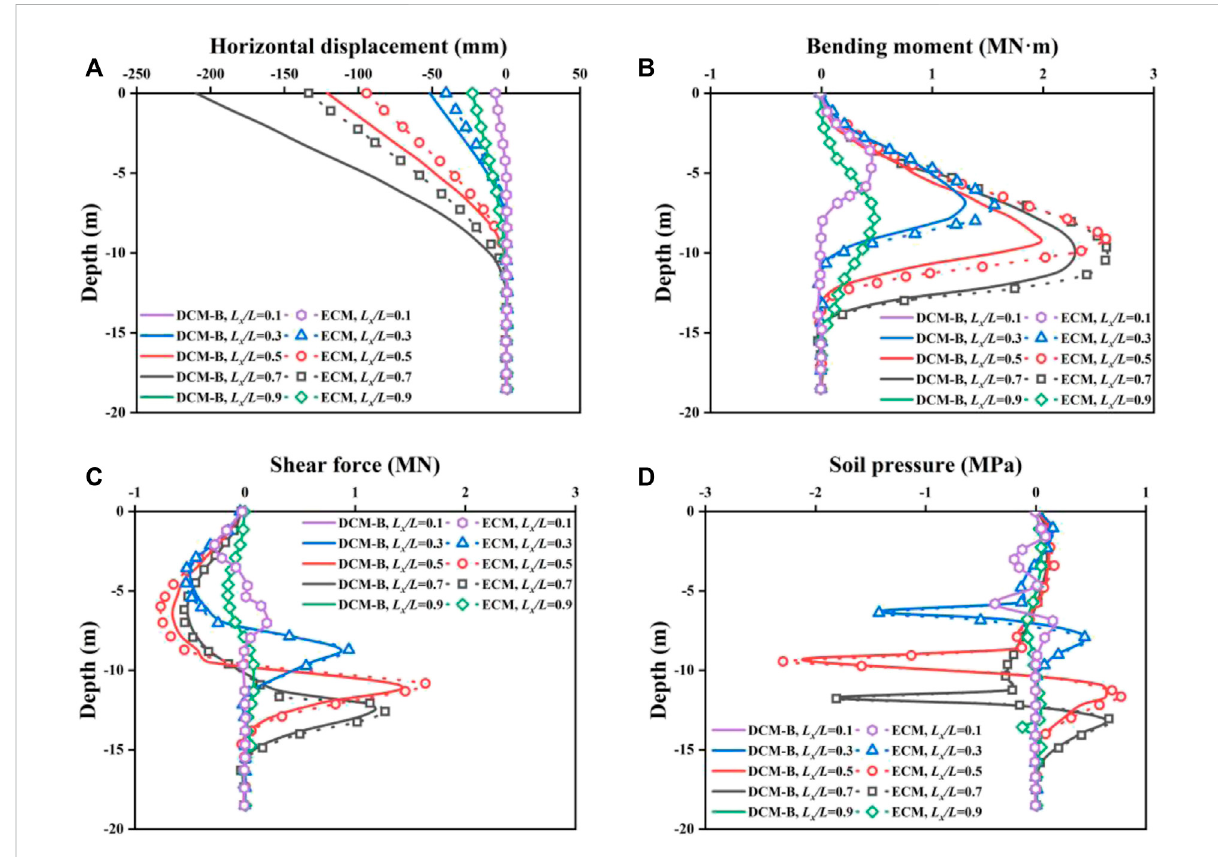
Figure 8 represents the relationship between the pile ’